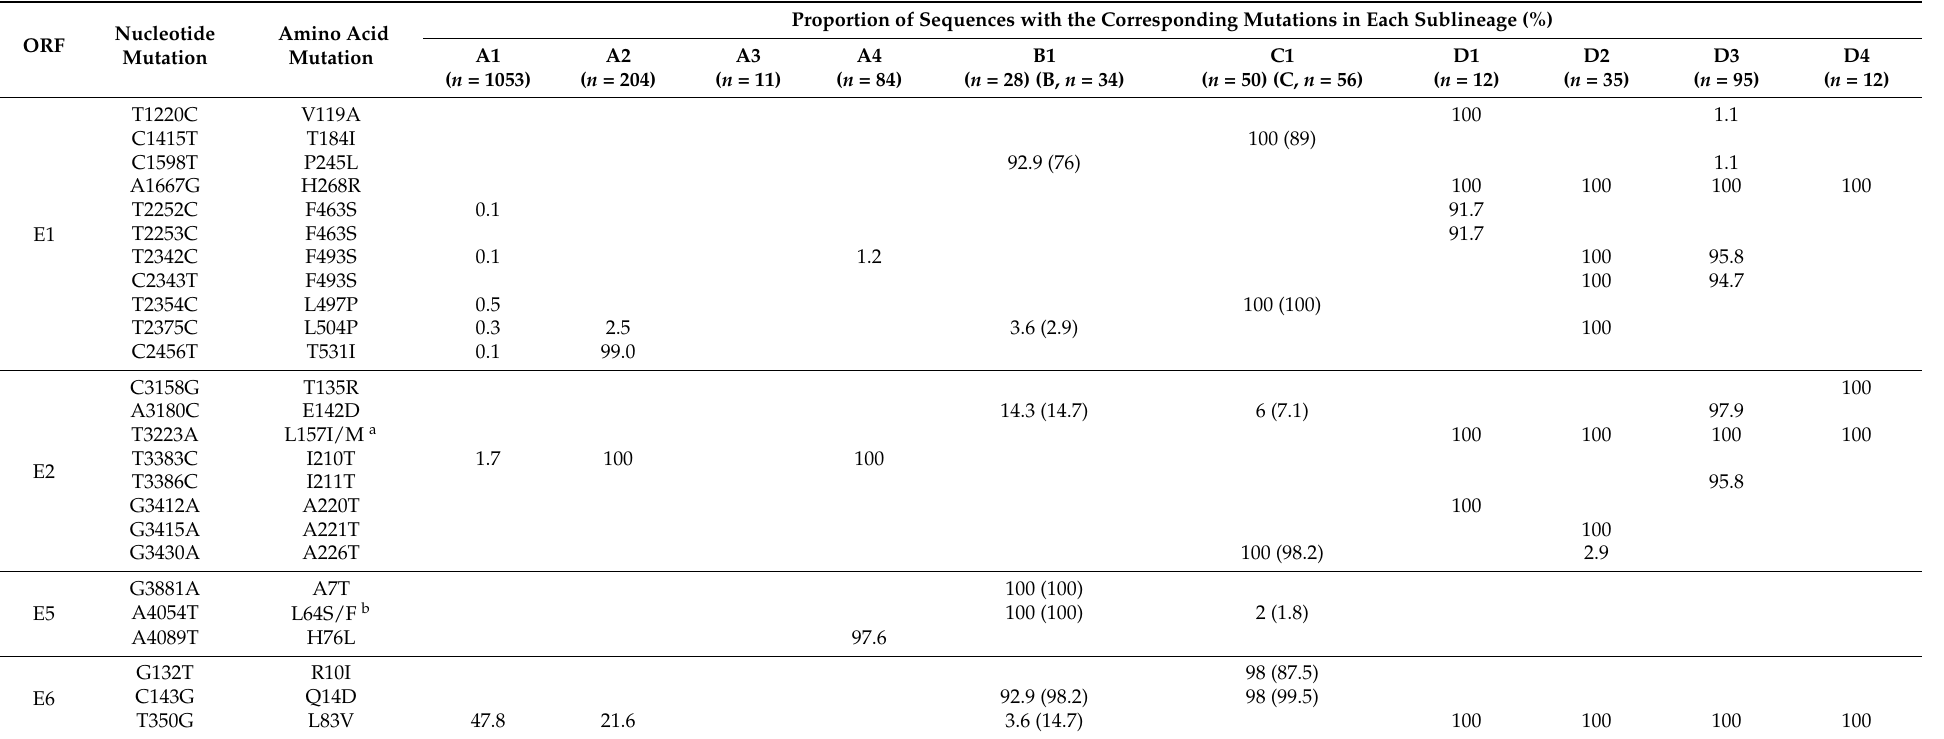
Table 1. Mutation profiles of HPV16